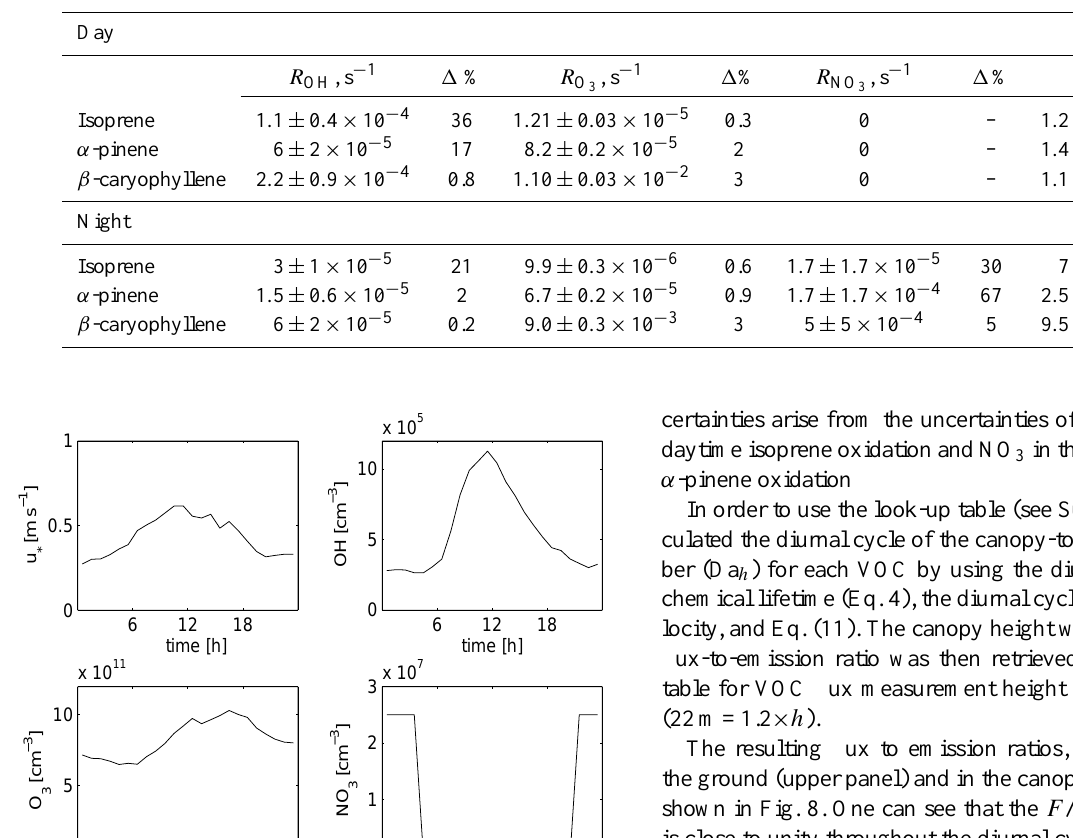
Table 3. Oxidative capacities of OH, O 3 and NO 3 to isoprene, α -pinene, and β -caryophyllene. 1 % is the proportion to the uncertainty to the total oxidative capacity of given VOC.